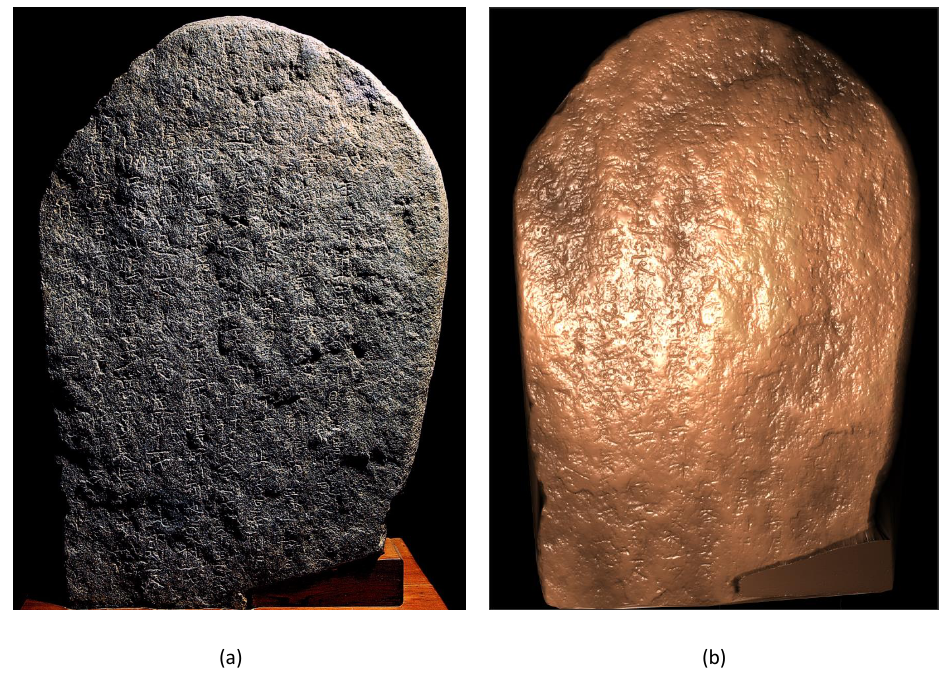
Figure 5. Musul-ojakbi stele: ( a ) 2D photograph; and ( b ) 3D scanned